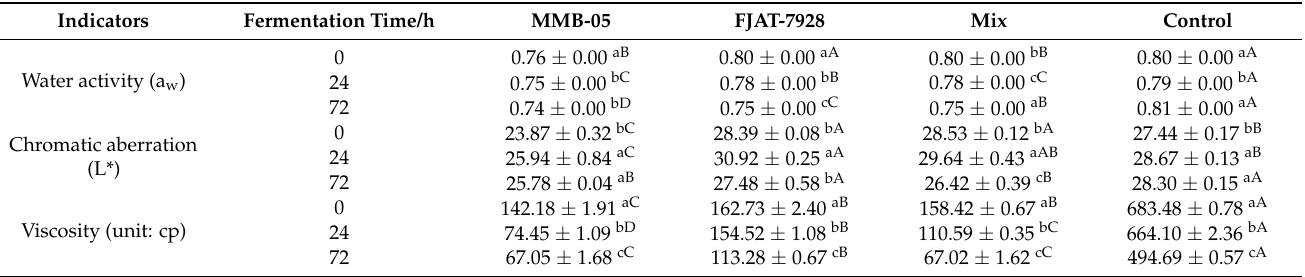
Table 2. Basic physical and chemical indexes of four groups of Porphyra yezoensis sauce (water activity, chromatic aberration, and